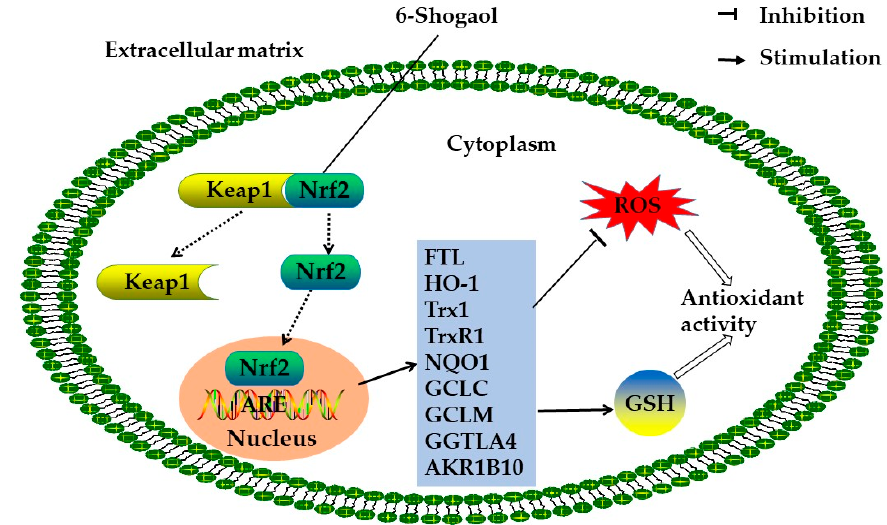
Figure 1. The potential mechanism for the antioxidant action of 6-shogoal: 6-shogoal leads to the translocation of Nrf2 into the nucleus and increases the expression of Nrf2 target genes by modifying Keap1 and preventing Nrf2 from proteasomal degradation. Thus, the level of GSH increases, and the level of ROS decreases. Abbreviations: Nrf2, nuclear factor erythroid 2-related factor 2; Keap1, Kelch-like ECH-associated protein 1; NQO1 , nicotinamide adenine dinucleotide phosphate (NADPH) quinone dehydrogenase 1; HO-1 , heme oxygenase-1; GCLC , glutamate-cysteine ligase catalytic subunit; GCLM , glutamate-cysteine ligase modifier subunit; Trx1 , thioredoxin 1; TrxR1 , thioredoxin reductase 1; AKR1B10, Aldo-keto reductase family 1 member B10; FTL , ferritin light chain; GGTLA4 , γ -glutamyltransferase-like activity 4; ROS, reactive oxygen species; GSH, glutathione; ARE, antioxidant response element.